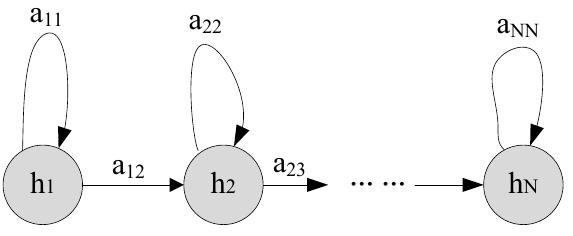
Figure 1. N-state left-to-right hidden Markov